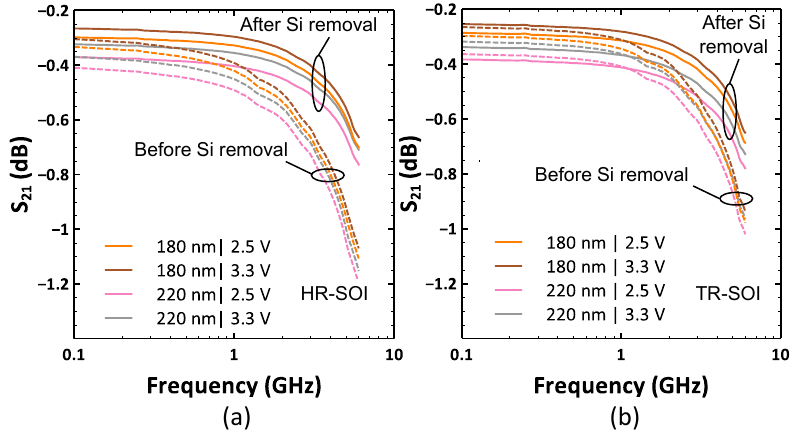
Figure 11. S 21 curves depicting the transmission characteristics of the switch before and after substrate removal for different gate lengths and V biasON values ( a ) HR-SOI; ( b ) TR-SOI.